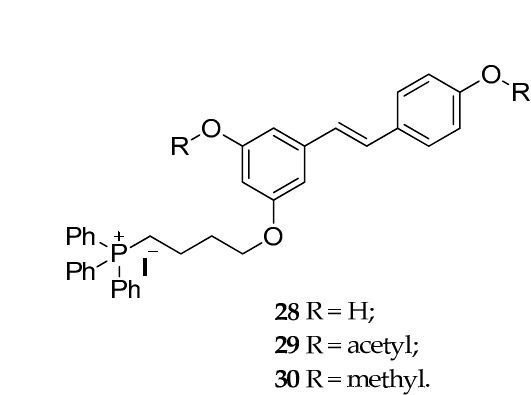
Figure 12. Chemical structures of RSV-triphenylphosphonium derivatives 25 – 30 .